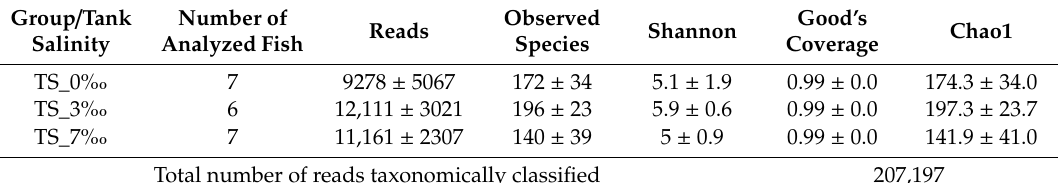
Table 1. Mean number of reads per sample assigned to OTUs, and alpha diversity metric values (without one sample with less than 737 reads) of the gut microbial community of pike from different environments.